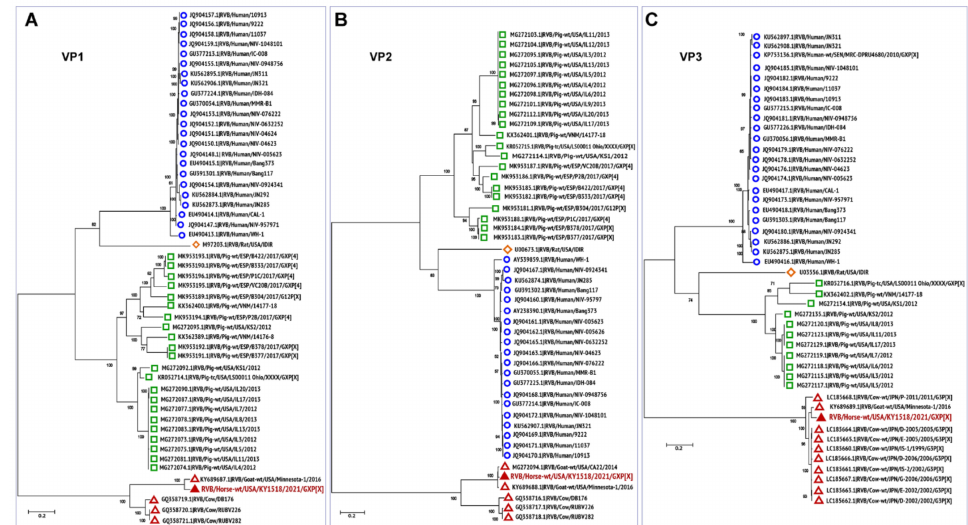
Figure 2. Phylogenetic trees of the complete protein-coding nucleotide sequences of the group B rotavirus VP4 ( A ), VP6 ( B ), and VP7 ( C ) genes. Maximum-likelihood analysis in combination with 1000 bootstrap replicates was used to derive trees based on the nucleotide sequences encoding respective proteins. The RVB strains are color-coded as human (open blue circle), murine (open orange diamond), porcine (open green square), and ruminant (open red triangle), with RVB/Horse-wt/USA/KY/1518/2021 (filled red triangle) highlighted in red font. A scale representing evolutionary distance that indicates the number of nucleotide substitutions per site is also shown in each panel. Bootstrap values are shown above branches to the left of major nodes.